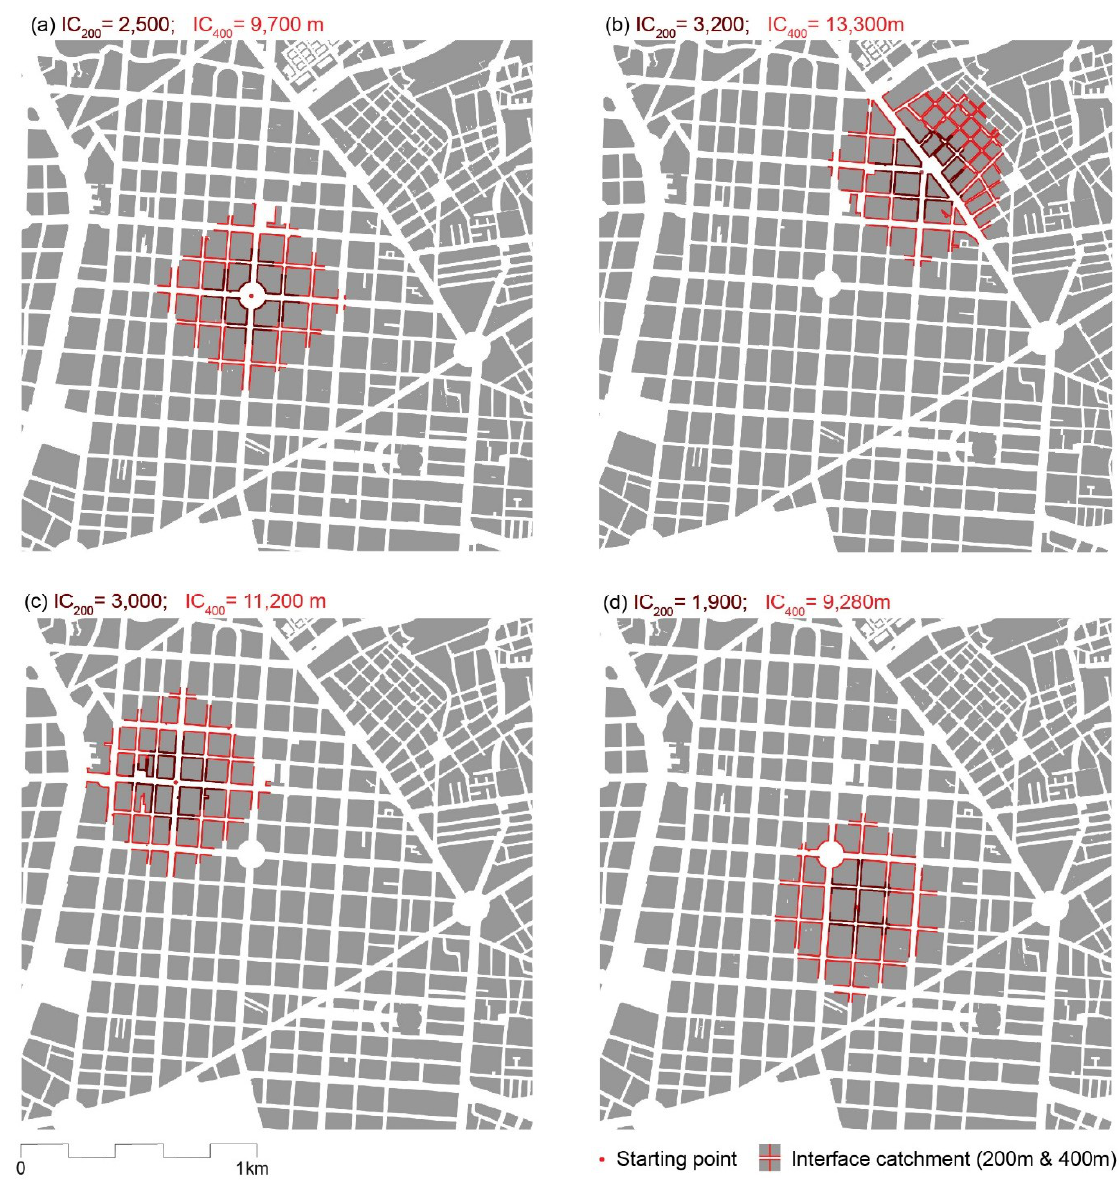
Figure 6. Measuring IC in Madrid.